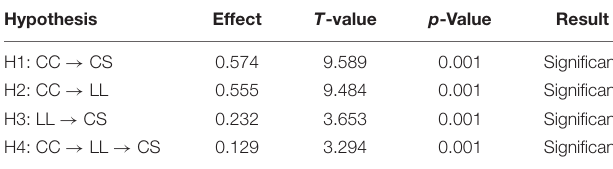
TABLE 3 | Serial mediation